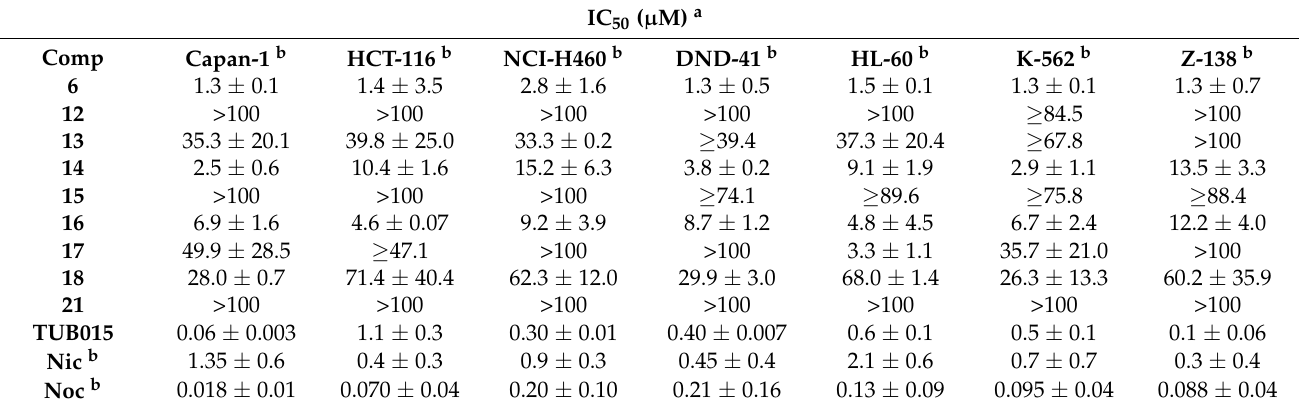
Table 1. Antiproliferative activity of the synthesized compounds against different tumor cell